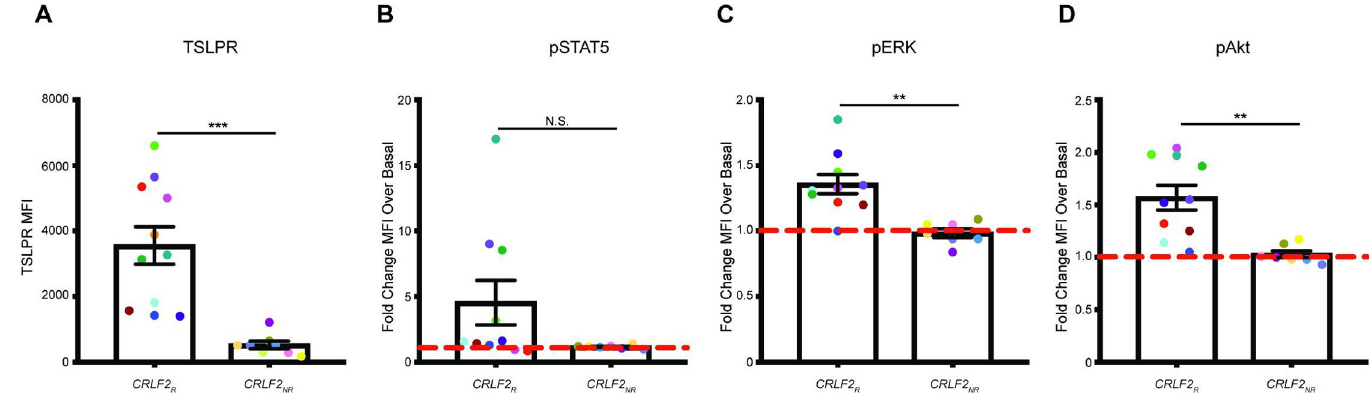
Fig 1. CRLF2 leukemias demonstrate TSLPR overexpression and increased signal transduction activity relative to CRLF2 R surface protein expression as determined by antibody staining and flow cytometry in cells from CRLF2 R and CRLF2 NR samples. Individual patient samples are shown in the same color in all figures and in S1 Table. ( B-D ) Induction of ( B ) pSTAT5, ( C ) pERK, and ( D ) pAkt in CRLF2 stimulation with 25ng/mL TSLP, presented as the fold change in MFI following TSLP stimulation relative to the basal condition. Samples JH721 and NL432 were not included in this analysis due to limitations in cell number. Error bars represent the standard error of the mean. Statistical significance was assessed using a two-sample t- test. ���� p < 0.0001, ��� p < 0.001, �� p < 0.01, � p < 0.05.